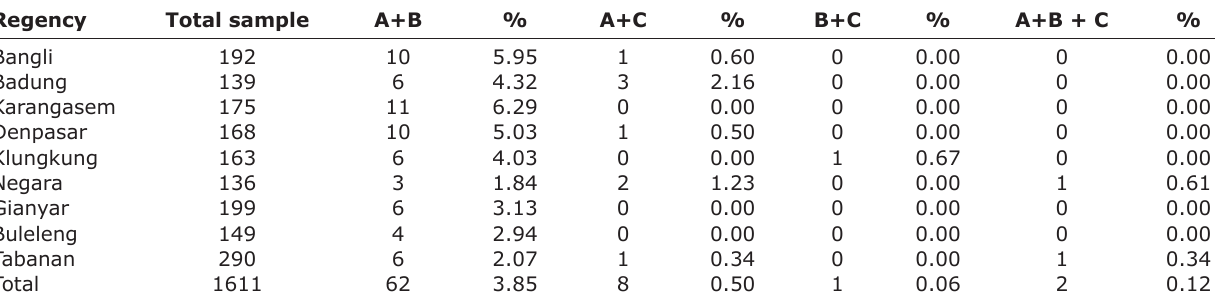
Table-6: The multiple infections of soil-transmitted helminths in free-roam dogs and its distribution in Bali Province. Regency Badung